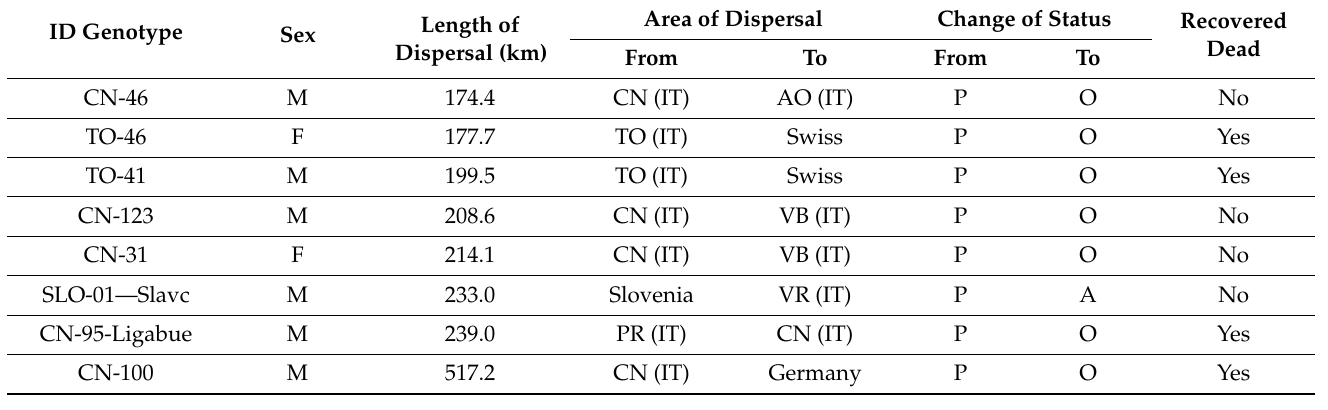
Table 1. Detailed information on the 7 dispersal events over 100 km in length. The area of provenience and arrival is indicated (the 2 letters indicate the Italian province), as is the status (P: pup/offspring, A: alpha/parent, O: other), and if the animal has been recovered dead.